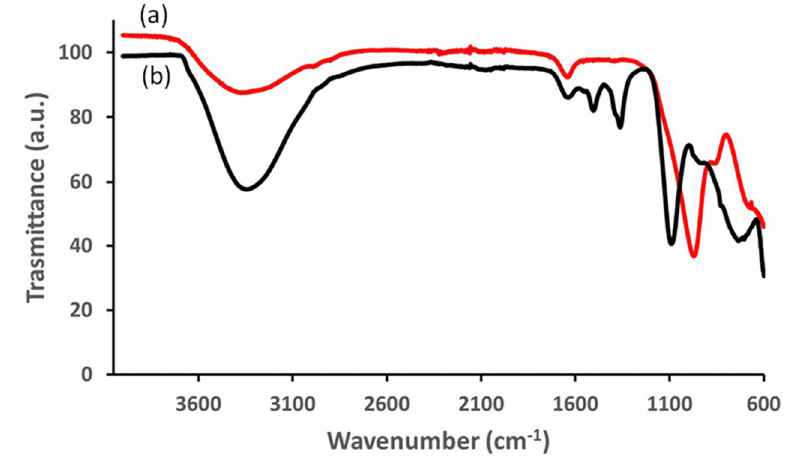
Figure 2. IR spectra for allophane ( a ) and for ZnAl-SO 4 LDH ( b ).